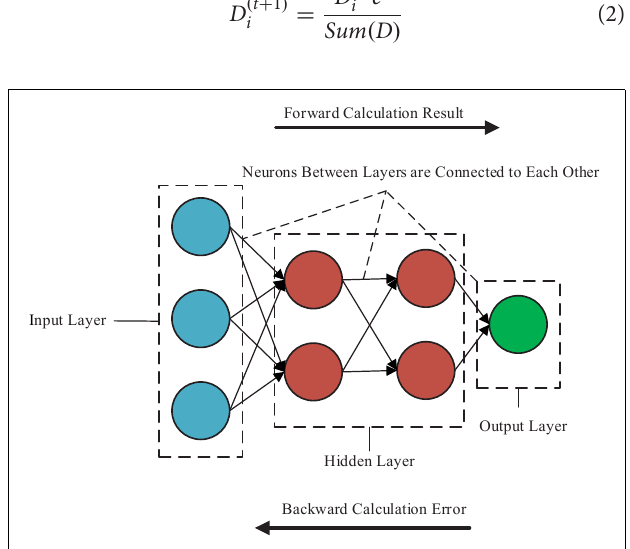
FIGURE 2 | Structure of neural network